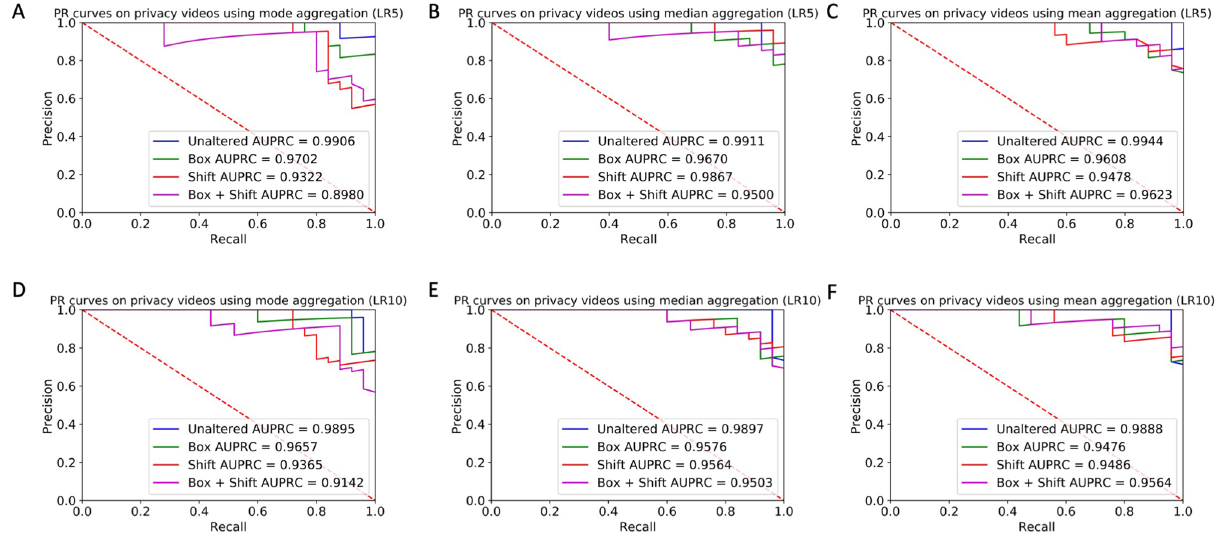
Figure 4. PR curves of the classifiers trained on aggregated features from the filtered crowd raters under each privacy condition. Precision is plotted against recall for different class cutoffs of the logistic regression classifier’s output probability. The color of the curve represents the privacy condition: blue represents unaltered videos, green represents face obfuscation, red represents pitch shift, and purple represents face obfuscation and pitch shift. Plots show aggregated results using the ( A , D ) mode, ( B , E ) median, and ( C , F ) round of the mean of the crowd worker responses. The ROC curves are shown for both the LR5 ( A – C ) and LR10 ( D – F ) classifiers. Area under the curves increasingly closer to 1.0 indicate increasingly better performance, and a value of 0.5 indicates random guessing by the classifier.